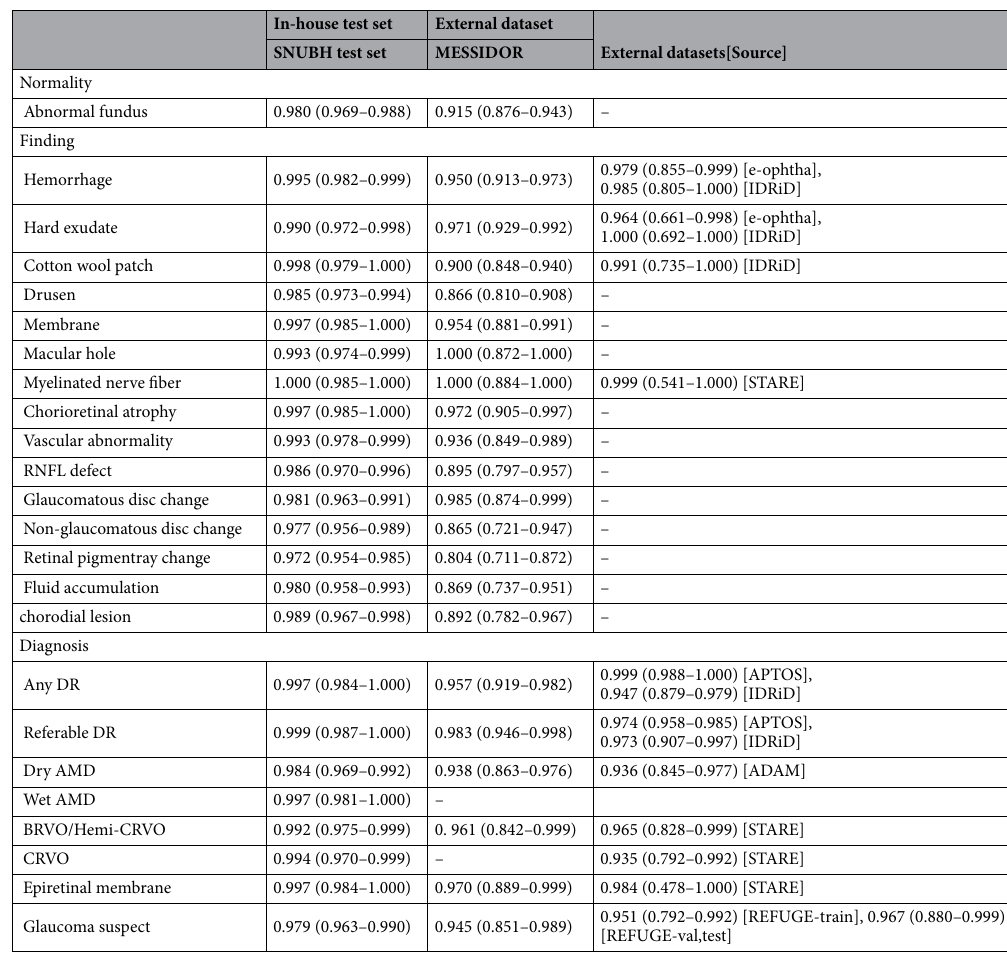
degeneration, BRVO Branch retinal vein occlusion, CRVO Central retinal vein occlusion, DR Diabetic retinopathy, RNFL Retinal nerve fiber